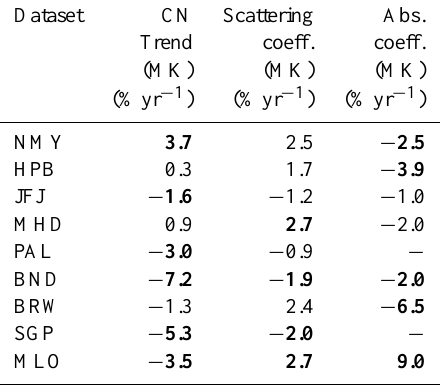
Table 4. Comparison of trends and trend significances between N and optical properties (from companion paper). The period of study is 2001–2010. Only MK trends are shown. Dataset CN Scattering Abs. Trend coeff. coeff. (MK) (MK) (MK) (%yr − 1 ) (%yr − 1 ) (%yr − 1 ) NMY 3.7 2.5 − 2.5 HPB 0.3 1.7 −